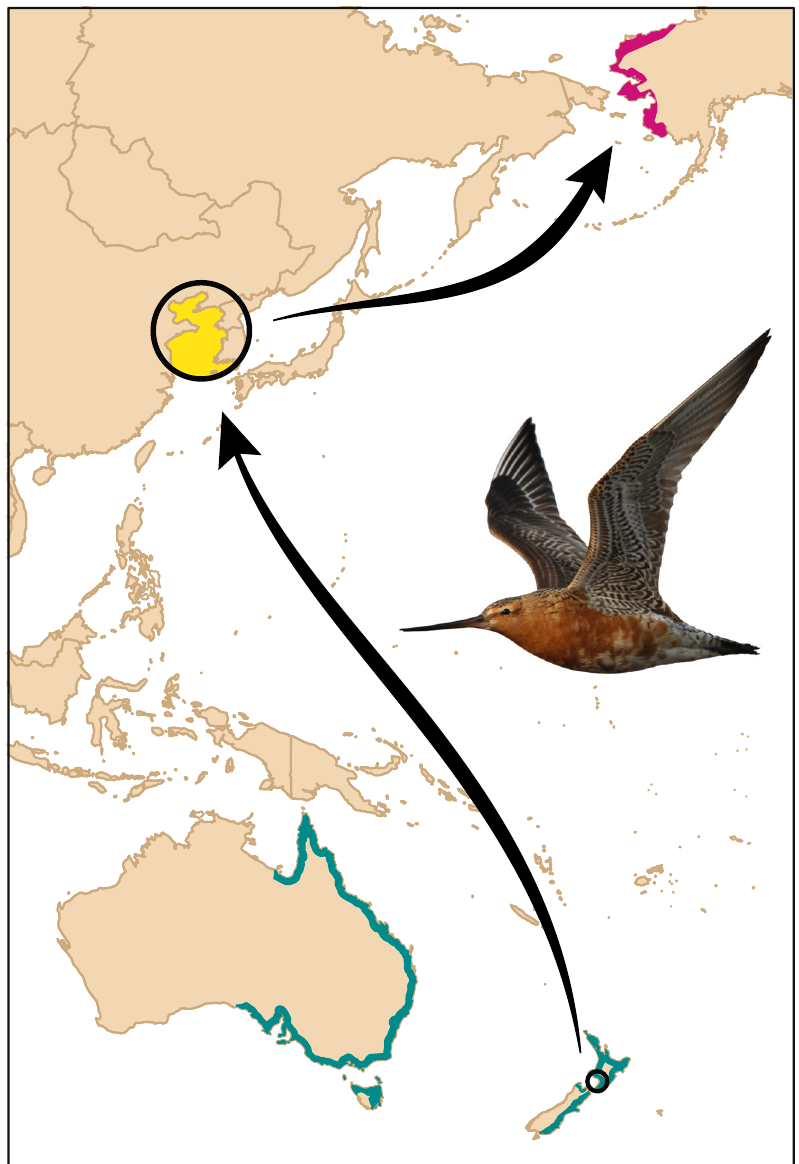
Fig. 1 Northward migration of bar-tailed godwits from the non-breeding range in New Zealand and Australia (in blue) to breeding areas in Alaska (in pink) in two non-stop fl ights, with a stopover in the Yellow Sea (in yellow). Field site in New Zealand indicated by a circle. Map made with Natural Earth. Photo: P.